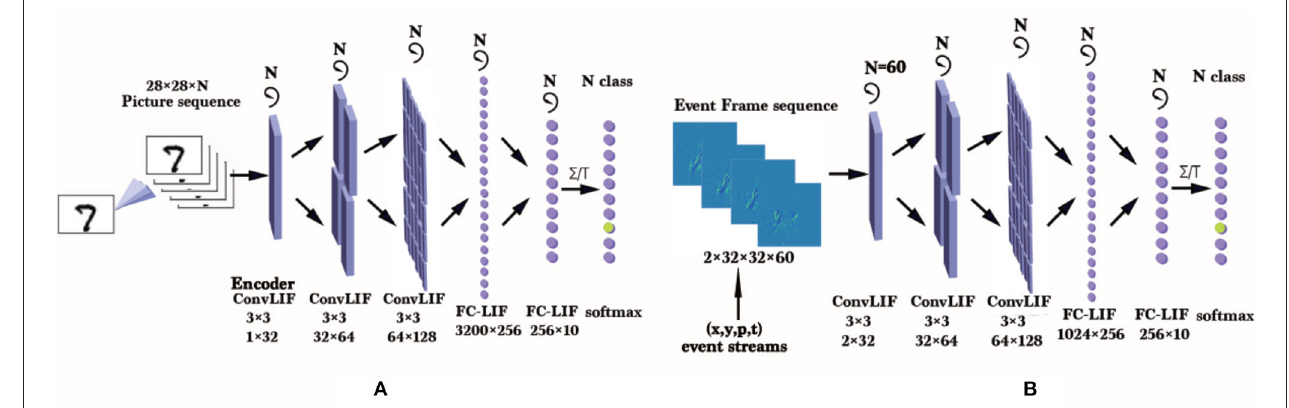
FIGURE 1 | (A) An approach for training the LIF-SNN (Dayan and Abbott, 2001) on an ANN-oriented dataset. Here, the SNN uses rate coding and an ANN-like structure, so it can be trained using frame data naturally. (B) Training an LIF-SNN with GPUs on a DVS-dataset (ES-dataset recorded by DVS). Here we need to accumulate events within a small period as an event frame and get an event frame sequence with N frames for training. On the neuromorphic processor, these asynchronous event data can be processed more